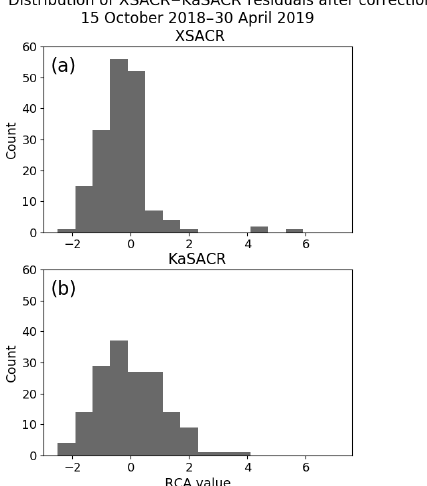
Figure 20. Histograms of daily mean RCA values for COR XSACR and KaSACR between 8 November 2018 and 30 April 2019. The XSACR RCA residual is shown in (a) after correction for piece- wise jumps. The KaSACR residual after correction by the piecewise polynomial curve is shown in (b)